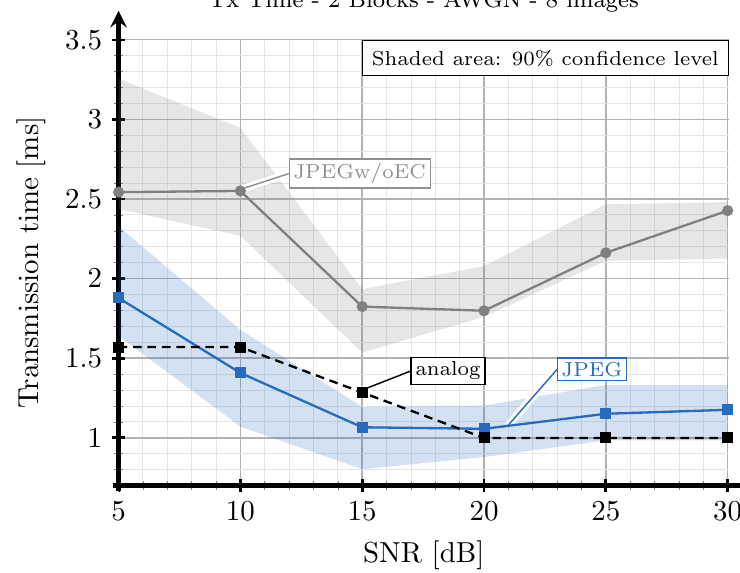
Figure 13. Average transmission time (considering 8 images) vs. SNR for two blocks and AWGN channel.